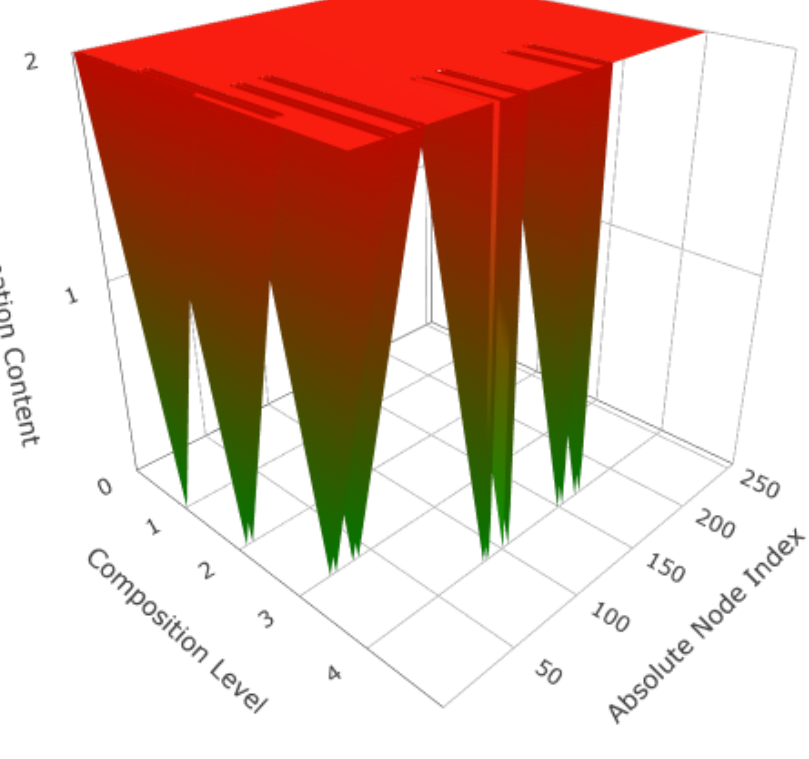
Figure 7. DPath Information for a DSpace traversal using Test Set